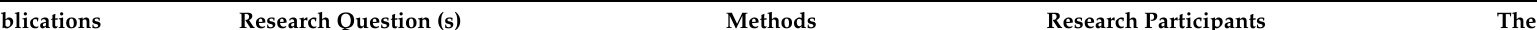
Table A1. List of the empirical papers included in the meta-synthesis (in chronological order of